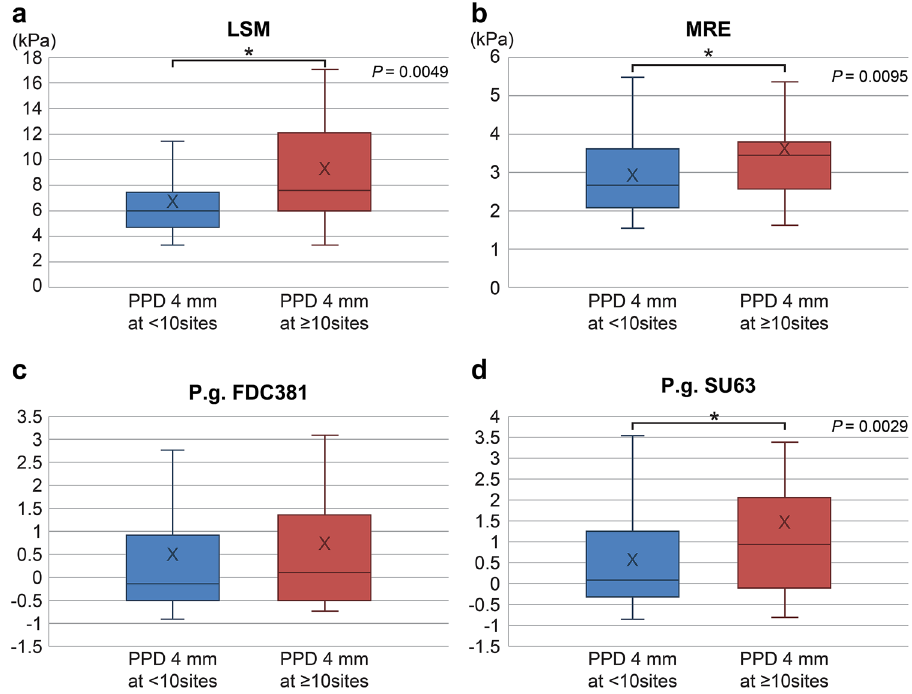
Figure 3. LSM ( a ), MRE ( b ), antibody titer for P. gingivalis FDC381 ( c ), and antibody titer for P. gingivalis SU63 ( d ) in patients with periodontal pockets ≥ 4 mm at a depth of < 10 mm or ≥ 10 sites. LSM liver stiffness measurement, MRE magnetic resonance elastography, PPD periodontal pocket